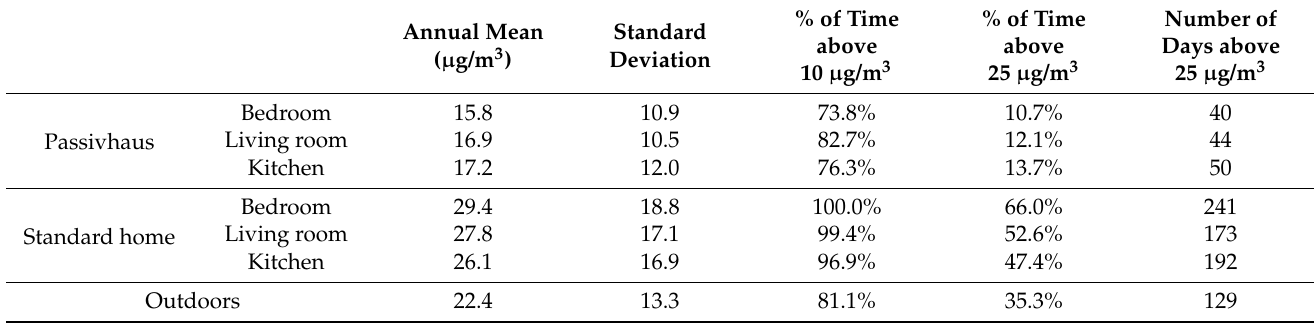
Figure 6. Annual PM 2.5 profile in the Passivhaus and standard dwellings. Source: Authors. Table 3. Annual PM 2.5 means compared to the recommended thresholds. Source: